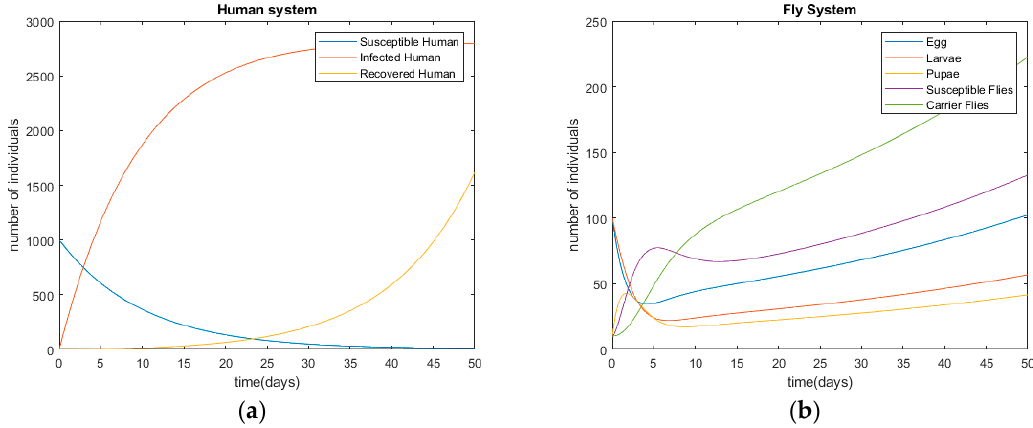
Figure 3. Diseases’ infection trends of diarrhea without control methods. ( a ) Human system; ( b ) fly system.